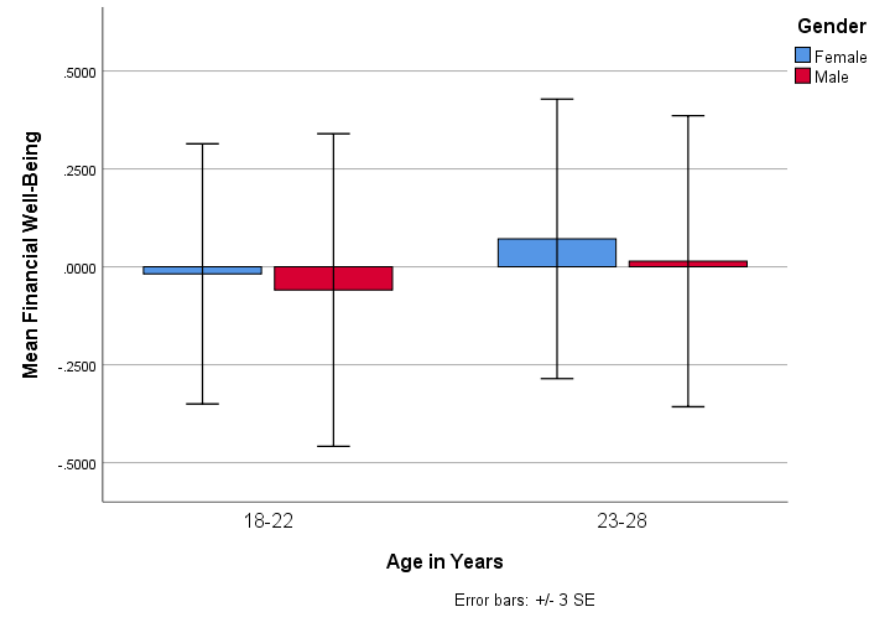
Figure 4. Distribution of financial well-being scores by age and